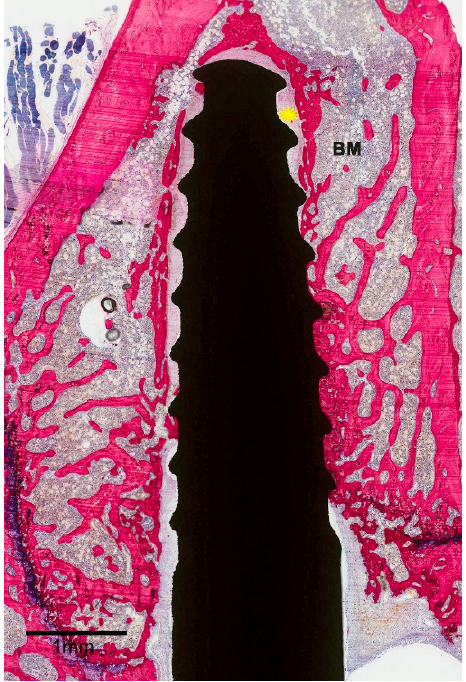
Figure 4. Histological image showing a “failed” implant. The implant was surrounded by a wide space filled with fibrous tissue (yellow star).